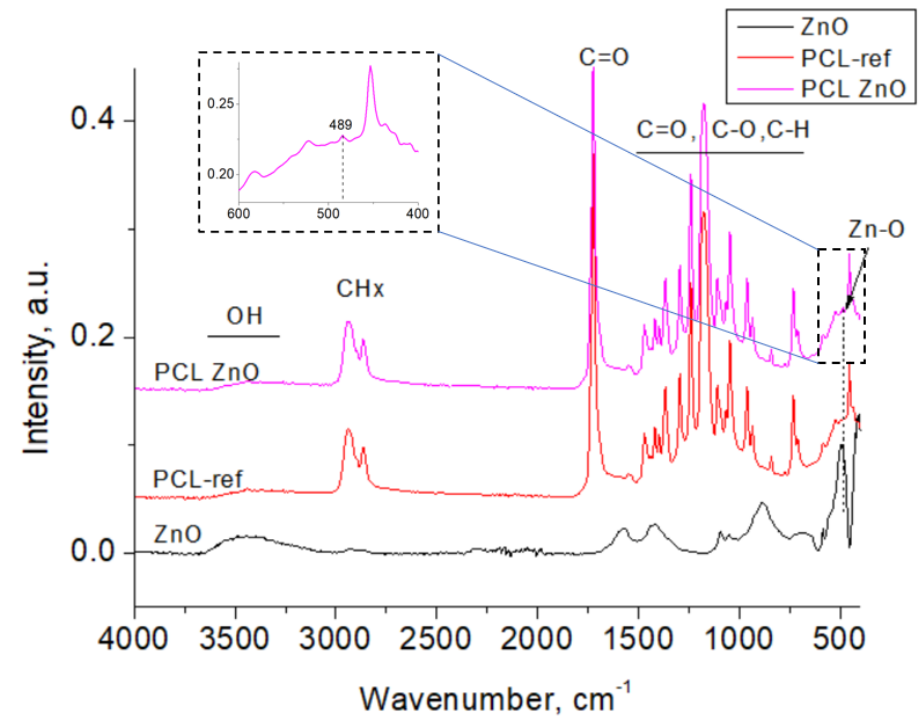
Figure 4. FTIR spectra of samples ZnO NPs, PCL-ref, and PCL-ZnO.